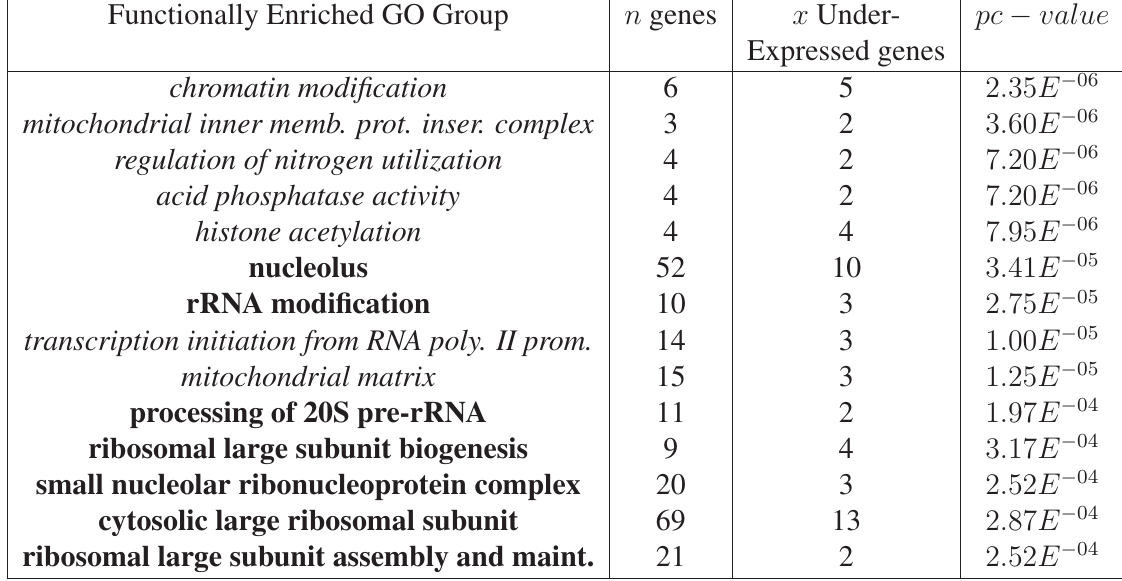
Table 3: Under-Expressed FEGs obtained by CGGA with a p − value = 6 . 88 E −